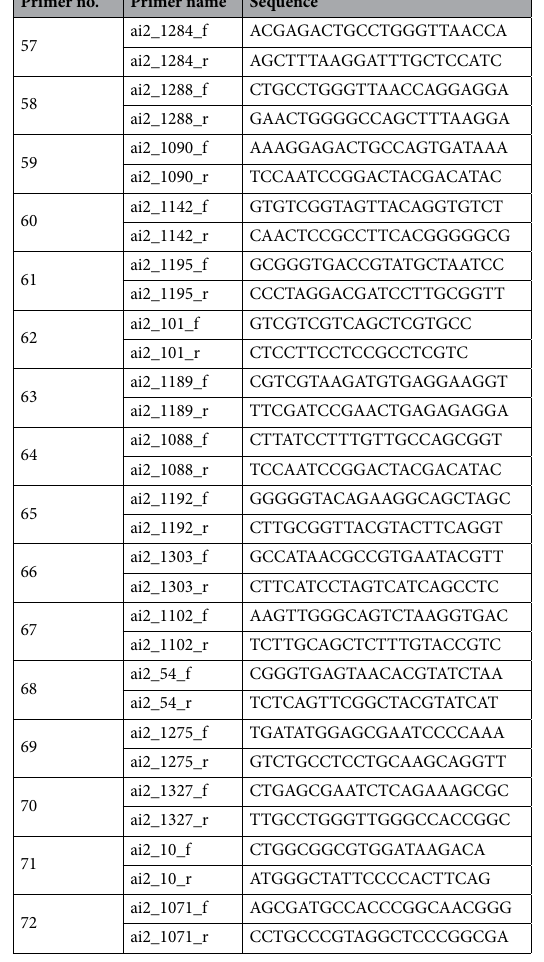
Table 1. Primer sets for the main experiment. Primer pair number, primer name and base sequence (5 ′ → 3 ′ ) used in the experiments for RNN-training are shown. Primers with the same primer pair number are used as a set of